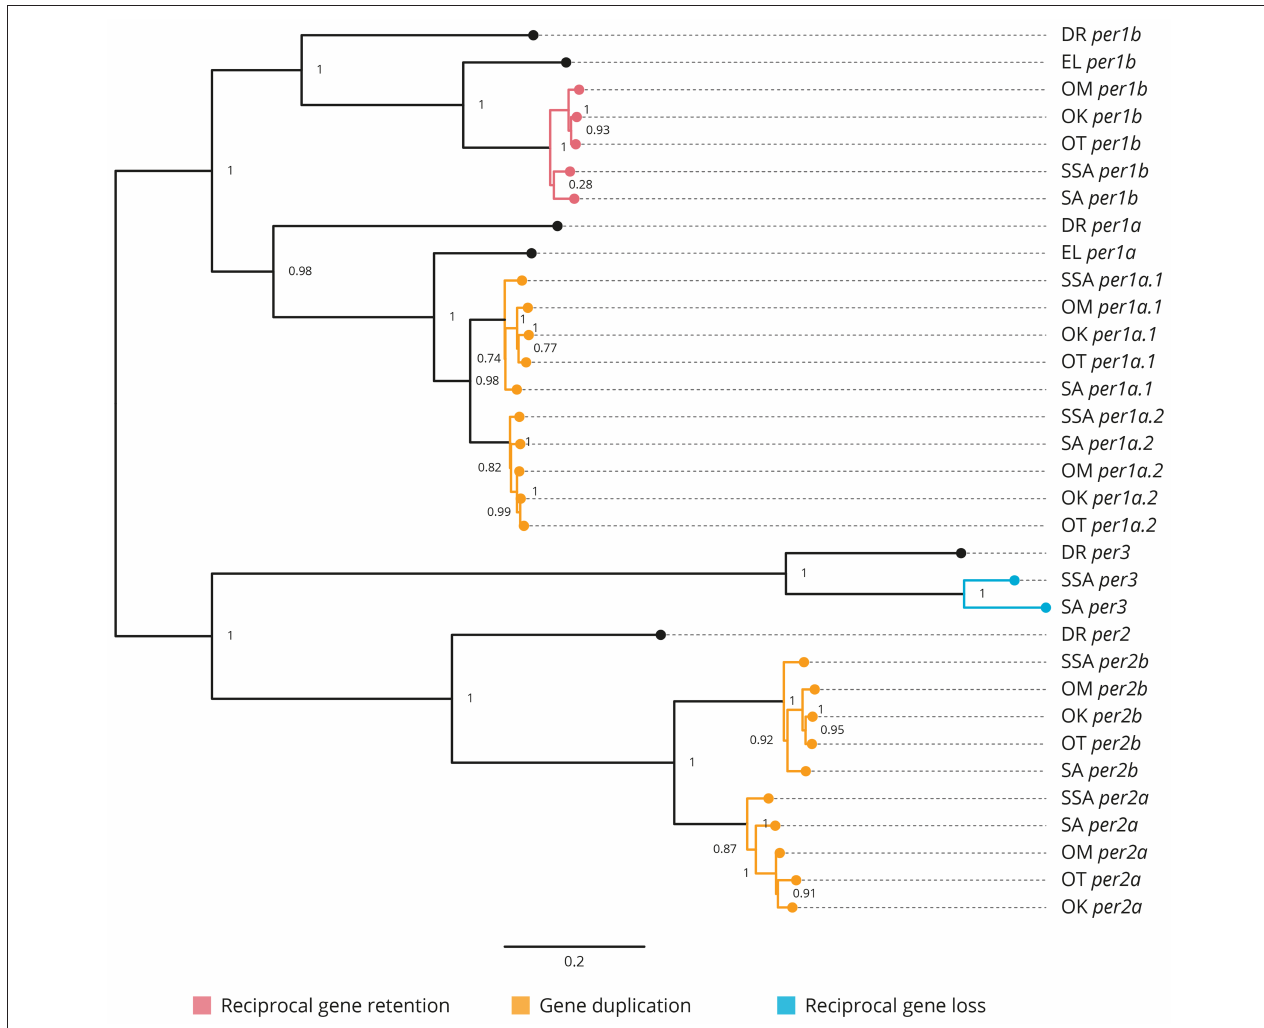
FIGURE 1 | Phylogenetic relationship of the period clock gene family ( per ). Gene family members from Danio rerio (DR), Esox Lucius (EL), Salmo salar (SSA), Salvelinus alpinus (SA), Oncorhynchus mykiss (OM), Oncorhynchus kisutch (OK), and Oncorhynchus tshawytscha (OT) were re-annotated. Values on the relevant node depict the bootstrap values. Reciprocal gene retention (red), gene duplication (orange), and reciprocal gene loss